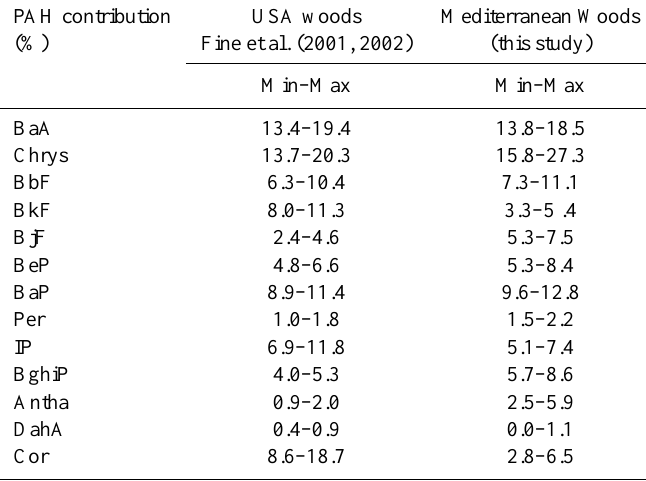
Table 5. PAH molecular fingerprints of wood combustion emissions from USA and Mediterranean